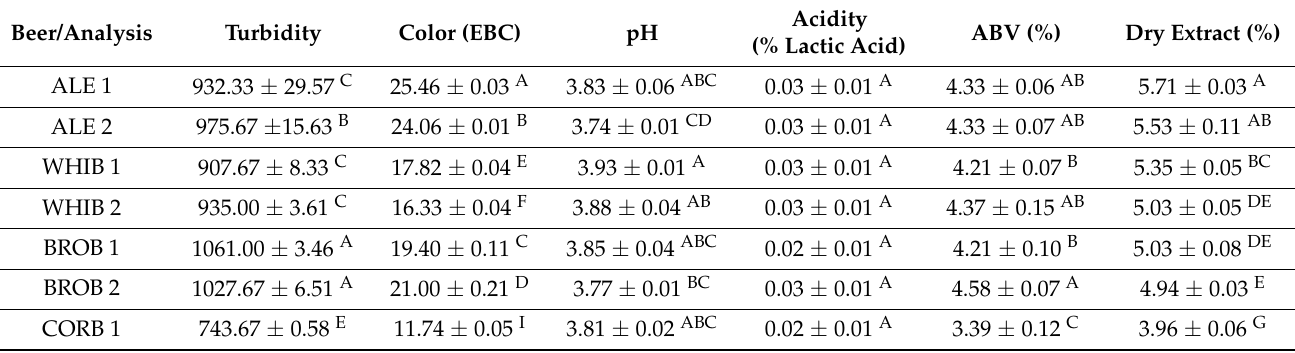
Table 3. Values of the beer physicochemical properties (mean ±